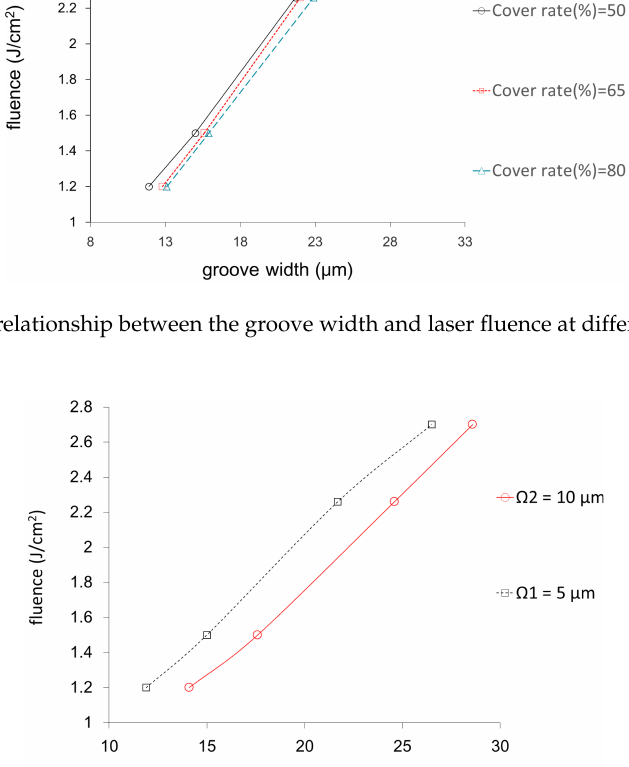
Figure 3. The relationship between the groove width and laser fluence at different spiral width.